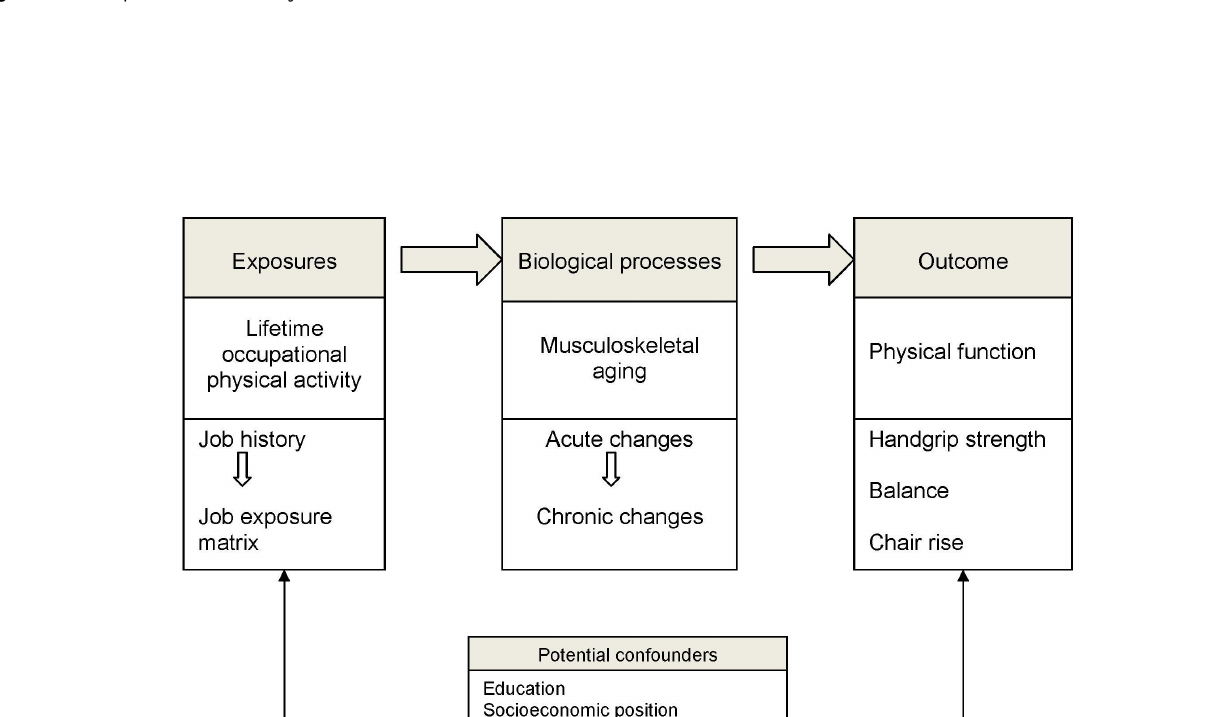
Figure 1. Conceptual model of